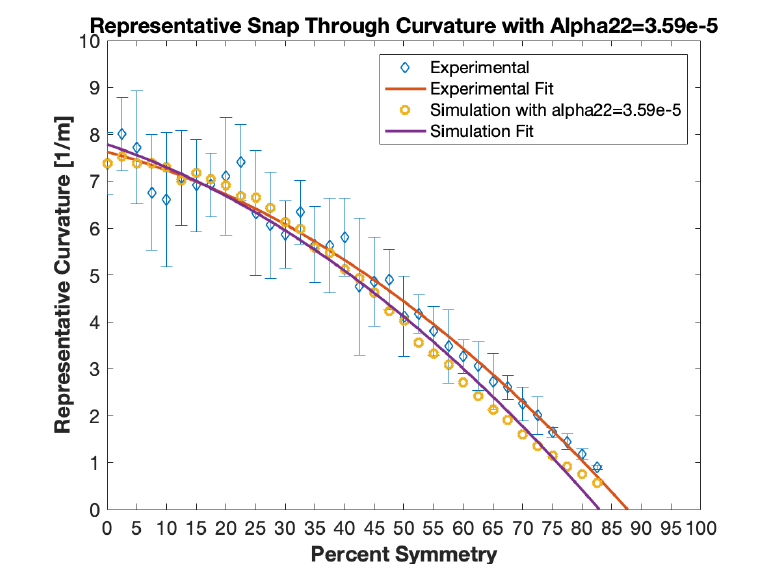
Figure 15. The snap through curvature versus the percent symmetry for all of the laminates simulated and studied that were bistable, using an α 22 value of 3.59 × 10 − 5 . Error bars on the experimental points show ± one standard deviation.